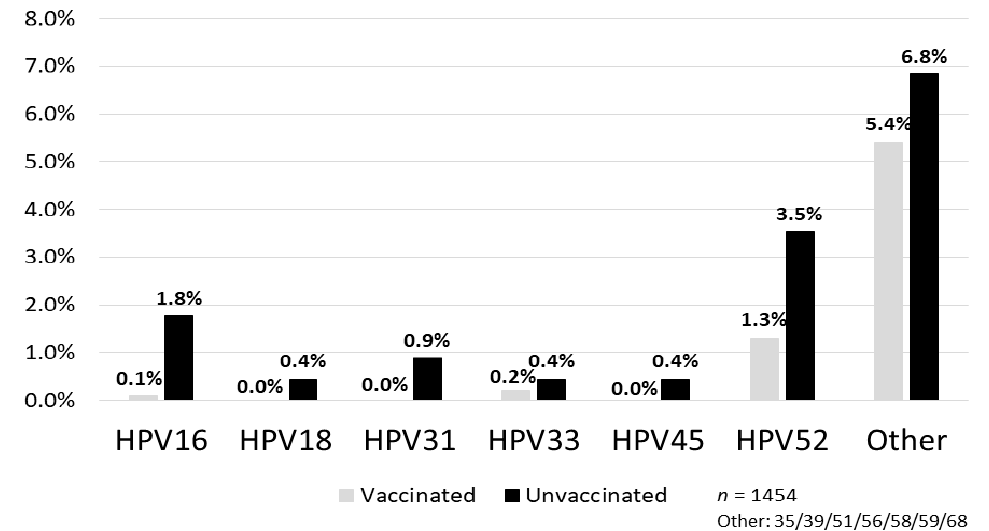
Figure 2. Prevalence of high-risk HPV type-specific infection. Prevalence of HPV16, 31 and 52 infection rates in the vaccinated group were obviously lower than that in the unvaccinated group, and no one had HPV18 or 45 infection in the vaccinated group [6].